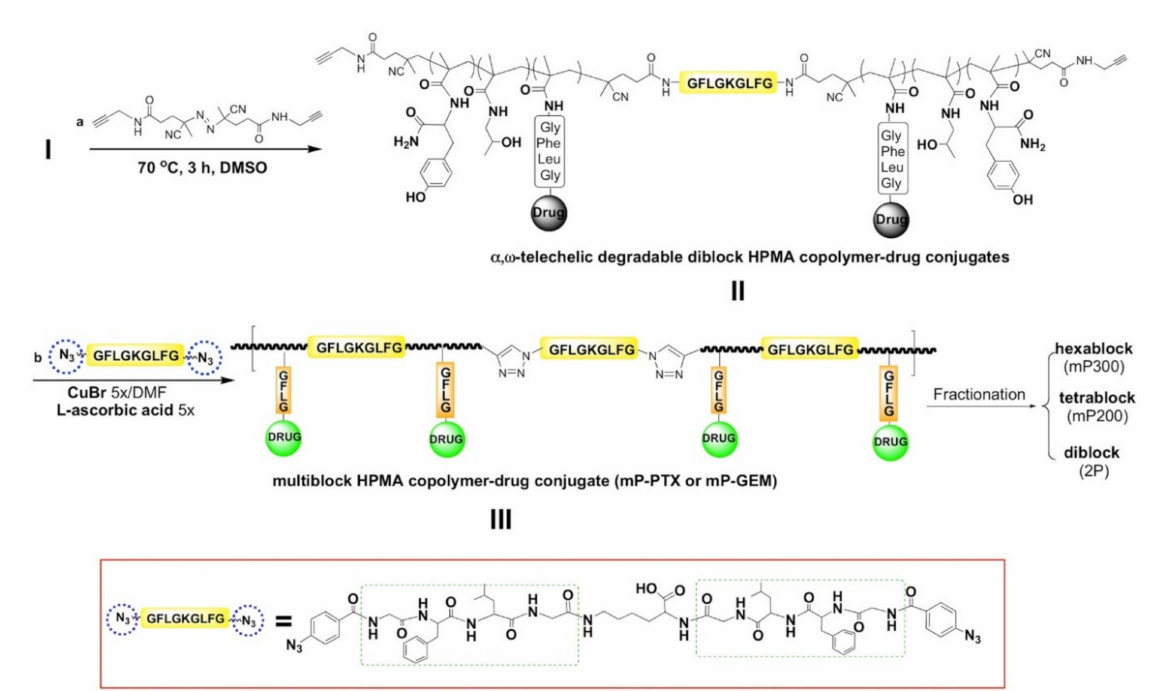
Figure 2. Synthesis of multiblock biodegradable N- (2-hydroxypropyl) methacrylamide (HPMA) copolymer (pHPMA)–drug conjugates. Reprinted with permission from [62]. Copyright (2017) American Chemical